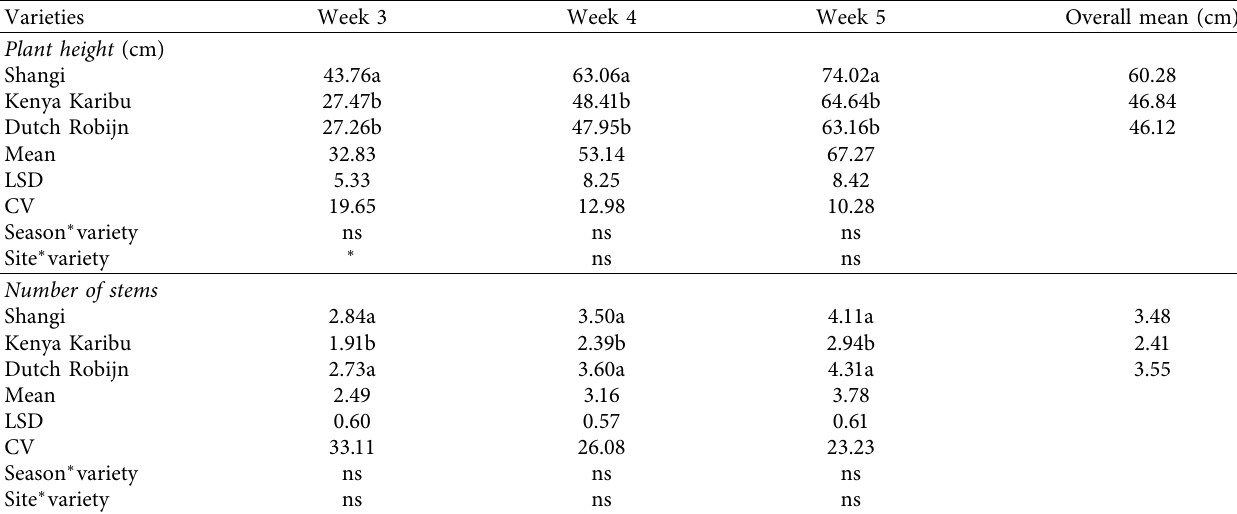
Table 10: Means of three potato varieties on plant height and number of stems at different weeks after